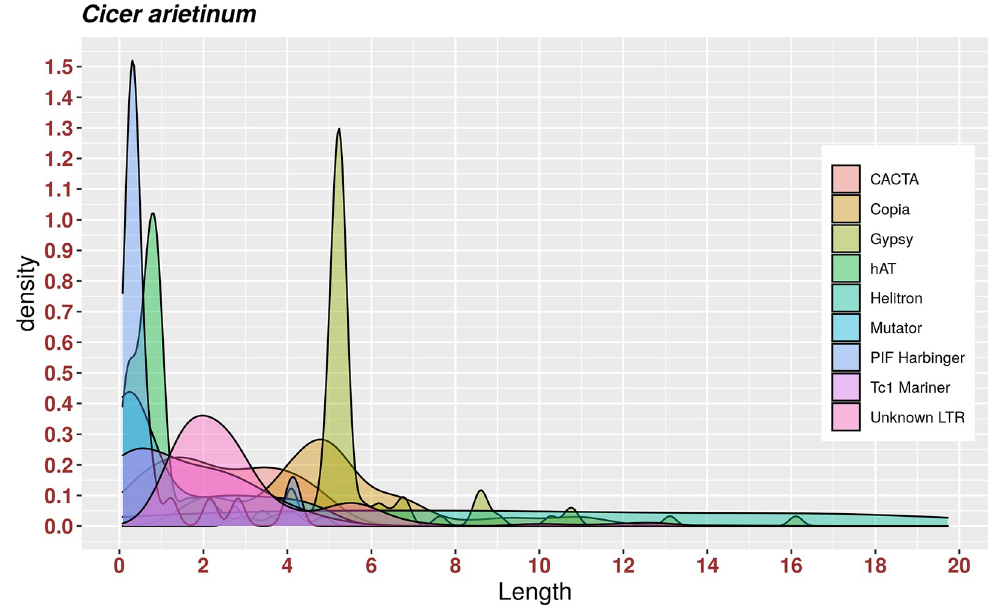
Fig 4. The distribution of C . arietinum TEs superfamilies according to their